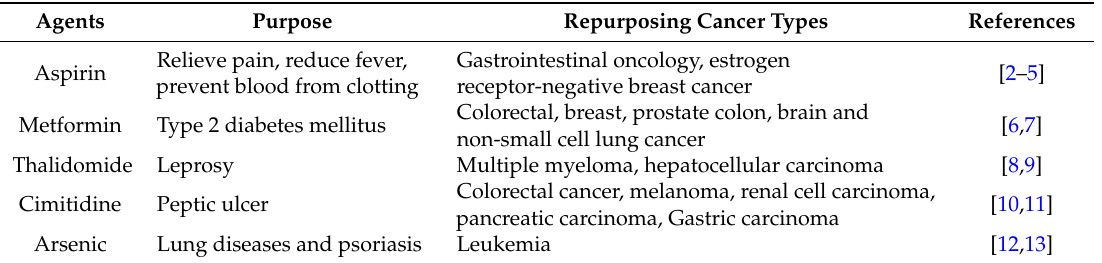
Table 1. Some representative repurposing agents for cancer